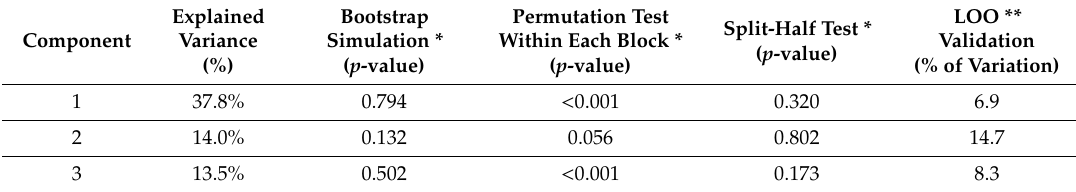
Figure 1. Contributions (%) of indicators and blocks to the dimensions: ( a ) the first dimension (DIM1) corresponds to 37.8% of inertia; ( b ) the second dimension (DIM2) explains 14.0% of inertia. Notes: estimation based on multiple factor analysis (MFA). Table 2. Validation results of MFA components’ explanatory